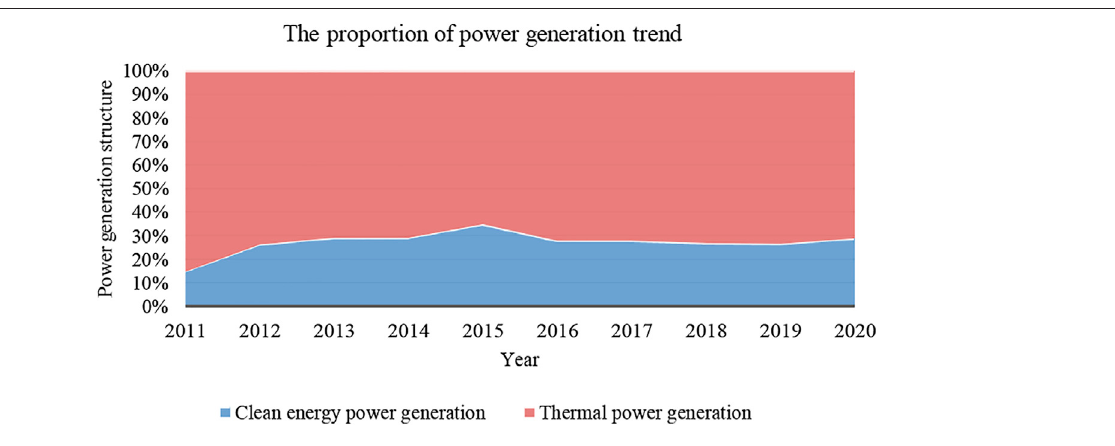
FIGURE 2 | The proportion of power generation